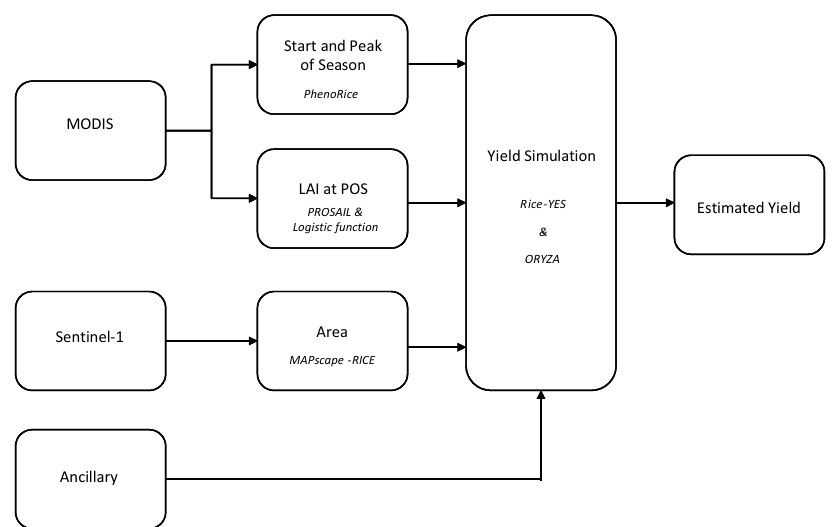
Figure 2. Schematic diagram of the components involved in the generation of spatially explicit rice yield using remote sensing (optical and SAR) and a crop growth model. Ancillary data include weather, soil, and agronomic management information. Rice-YES, Rice Yield Estimation System.